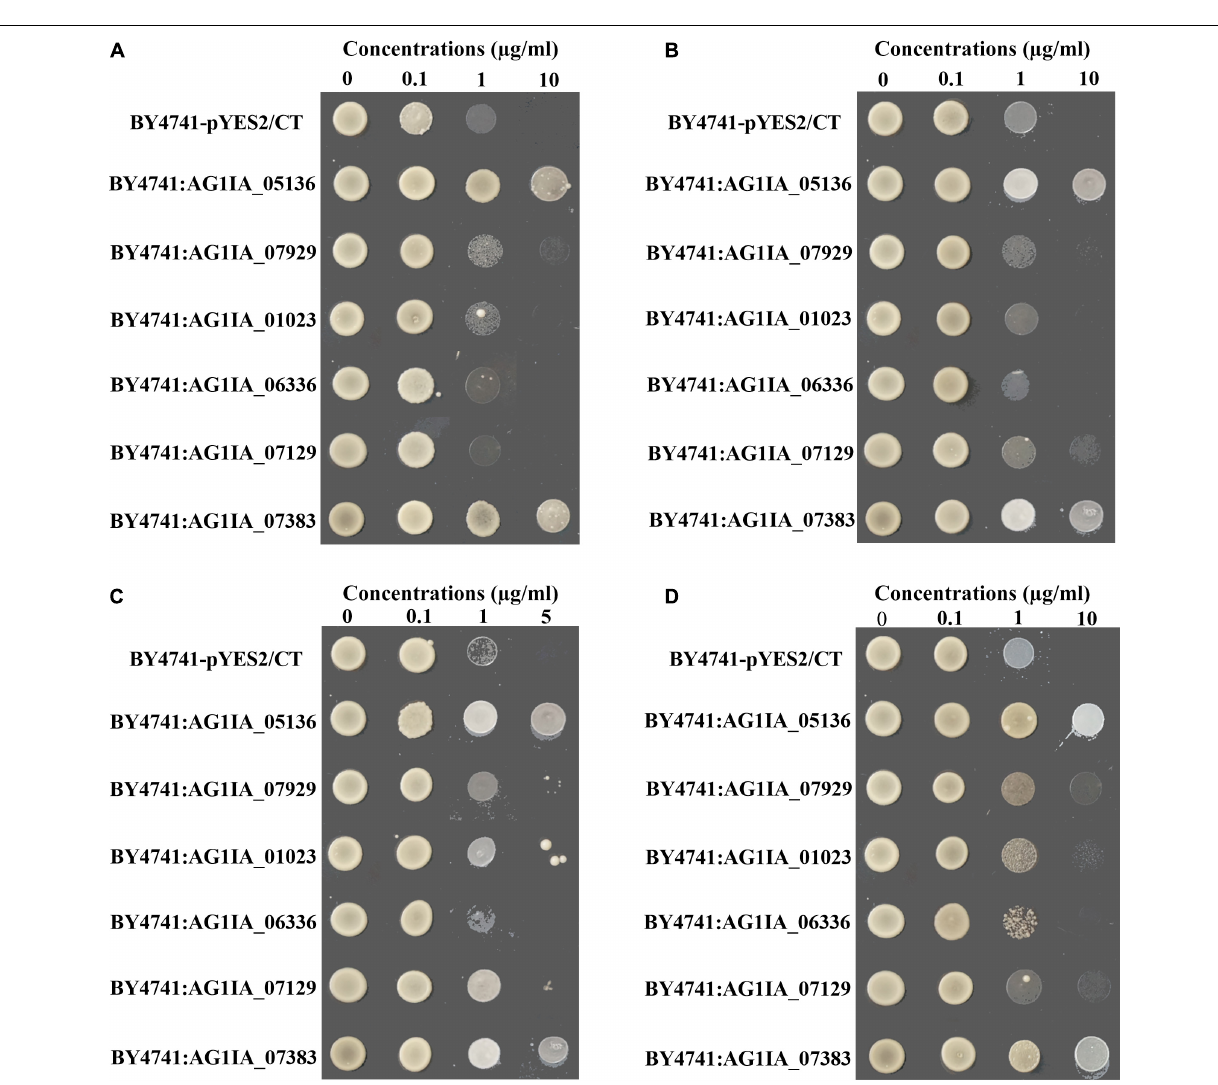
FIGURE 5 | Heterologous expression of the cytochrome P450 genes AG1IA_05136 , AG1IA_01023 , AG1IA_07129 , AG1IA_07929 , and AG1IA_06336 and glutathione transferase gene AG1IA_07383 in a drug-hypersensitive Saccharomyces cerevisiae strain BY4741. The sensitivity of the transformants were tested on solid synthetic dextrose minimal agar medium lacking uracil, containing 2% galactose and amended with different concentrations of SYP-14288 (A) , fluazinam (B) , chlorothalonil (C) , and difenoconazole (D) . Saccharomyces cerevisiae strain BY4741 was transformed with expression vector pYES2/CT (BY4741-pYZS2/CT), with P450 genes AG1IA_05136 (BY4741:AG1IA_05136), AG1IA_07929 (BY4741:AG1IA_07929), AG1IA_01023 (BY4741:AG1IA_01023), AG1IA_06336 (BY4741:AG1IA_06336), and AG1IA_07129 (BY4741:AG1IA_07129) and with glutathione S-transferase gene AG1IA_07383 (BY4741: